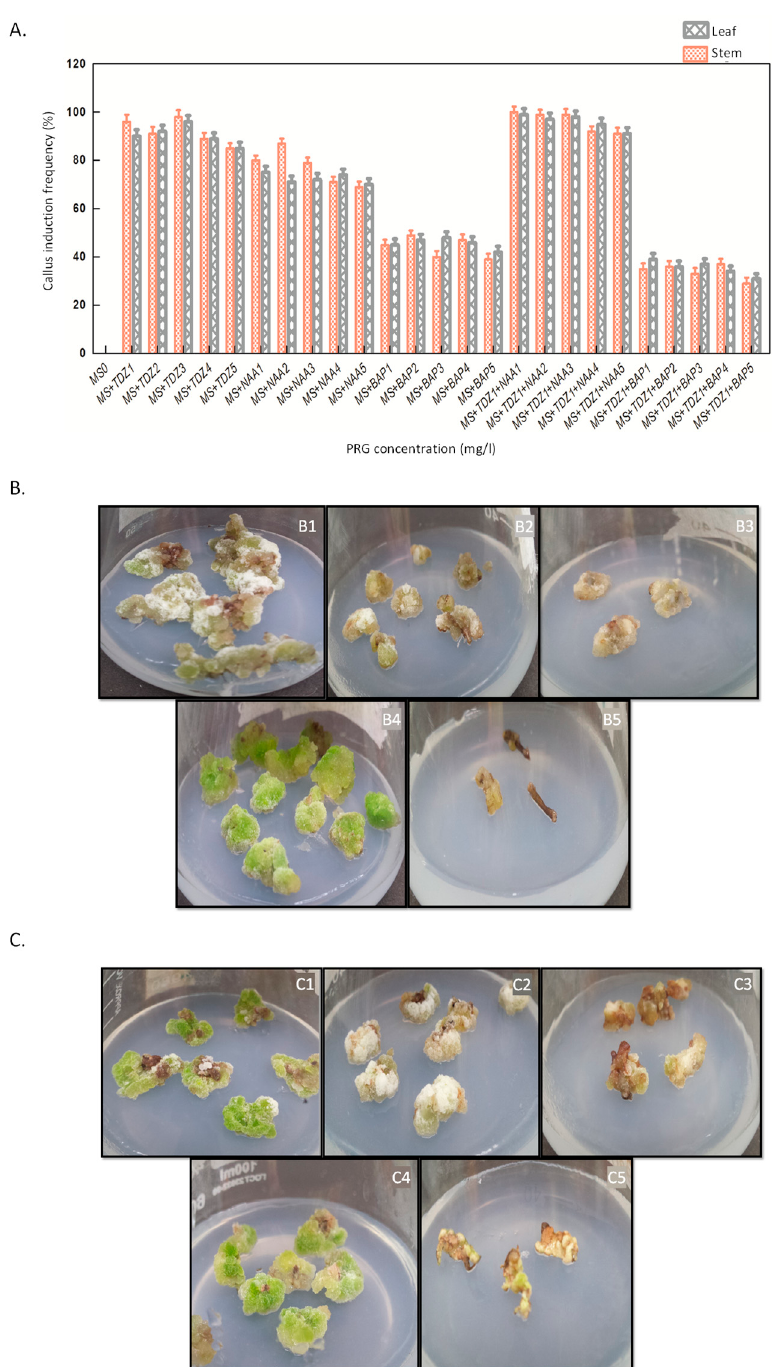
Figure 1. ( A ) Callus induction frequency (%) for stem and leaf explants under different PGRs concentrations. Values are means ± SE from three replicates; ( B ) Effect of 5 weeks old culture media containing various PGRs on callus induction and growth of stem explants; ( B1 ) TDZ 1.0 mg/L; ( B2 ) NAA 4.0 mg/L; ( B3 ) BAP 2.0 mg/L; ( B4 ) 1:1 TDZ 1.0 + NAA 1.0 mg/L; ( B5 ) TDZ 1.0 + BAP 4.0 mg/L; ( C ) Effect of 5 weeks old culture media containing various PGRs on callus induction and growth of leaf explants; ( C1 ) TDZ 3.0 mg/L; ( C2 ) NAA 3.0 mg/L; ( C3 ) BAP 4.0 mg/L; ( C4 ) TDZ 1.0 + NAA 1.0 mg/L; and ( C5 ) TDZ 1.0 + BAP 5.0 mg/L.